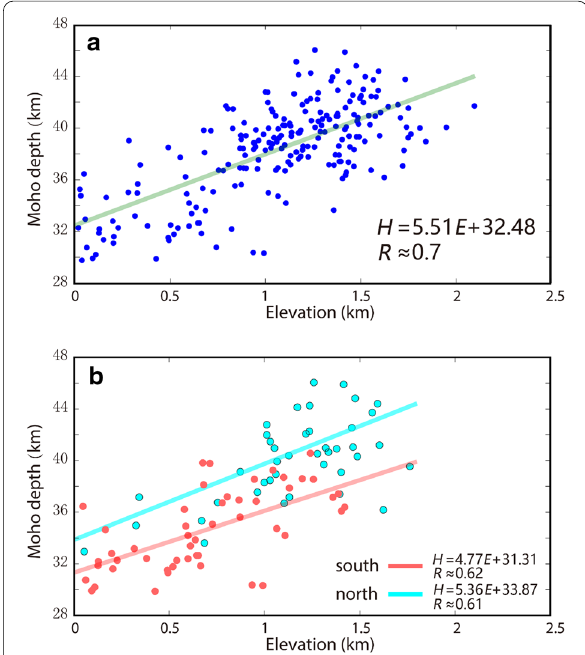
Fig. 7 a Correlation of elevation and the Moho depth in the research region. The green line is the linear regression curve. b The red and blue dots represent the H - κ stacking results in the northern and southern Shanxi rift and its adjacent regions, respectively. The lines give the approximate trends for depth of Moho versus